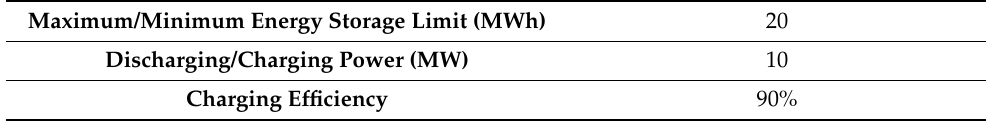
Figure 4. The forecasted wind power curve in p.u. Table 2. Battery Storage System’s Technical